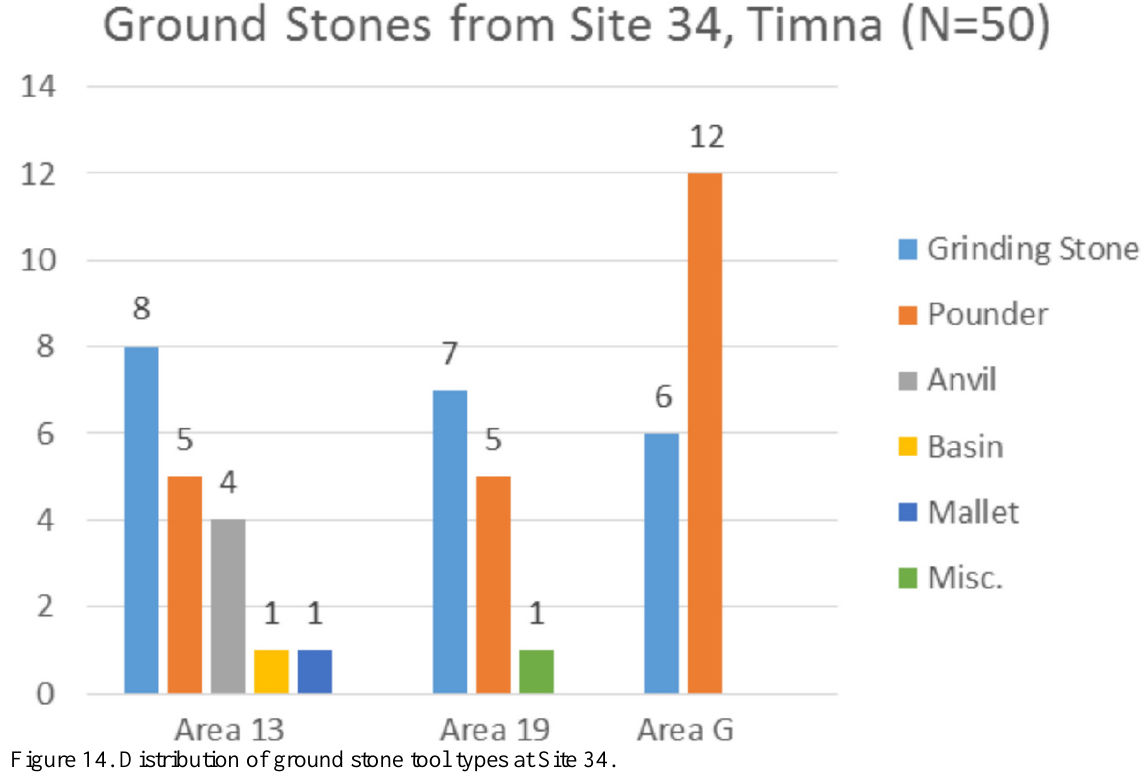
Figure 14. Distribution of ground stone tool types at Site 34.